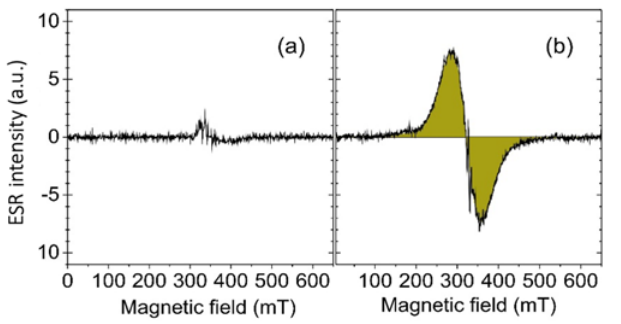
Figure 6. Room temperature X-band (9.54 GHz) Electron Spin Resonance (ESR) spectra of ( a ) an aorta isolated from a Apoe − / − mouse untreated (control) and ( b ) from a Apoe − / − mouse after NE-P3 (#5) injection.